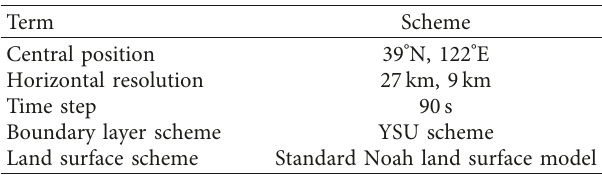
Figure 1: (a) Simulation domain; (b) land use categories in the control experiment (CE); (c) land use categories in sensitivity experiment 1 (SE_1). The numbers on the legend bar represent the 20 MODIS land use categories modified by the IGBP (1: evergreen needleleaf forest; 2: evergreen broadleaf forest; 3: deciduous needleleaf forest; 4: deciduous broadleaf forest; 5: mixed forest; 6: closed shrubland; 7: open shrubland; 8: woody savanna; 9: savanna; 10: grassland; 11: permanent wetland; 12: cropland; 13: urban and built-up land; 14: cropland/ natural vegetation mosaic; 15: snow and ice; 16: barren or sparsely vegetated; 17: water; 18: wooded tundra; 19: mixed tundra; 20: barren tundra). Table 2: Simulation